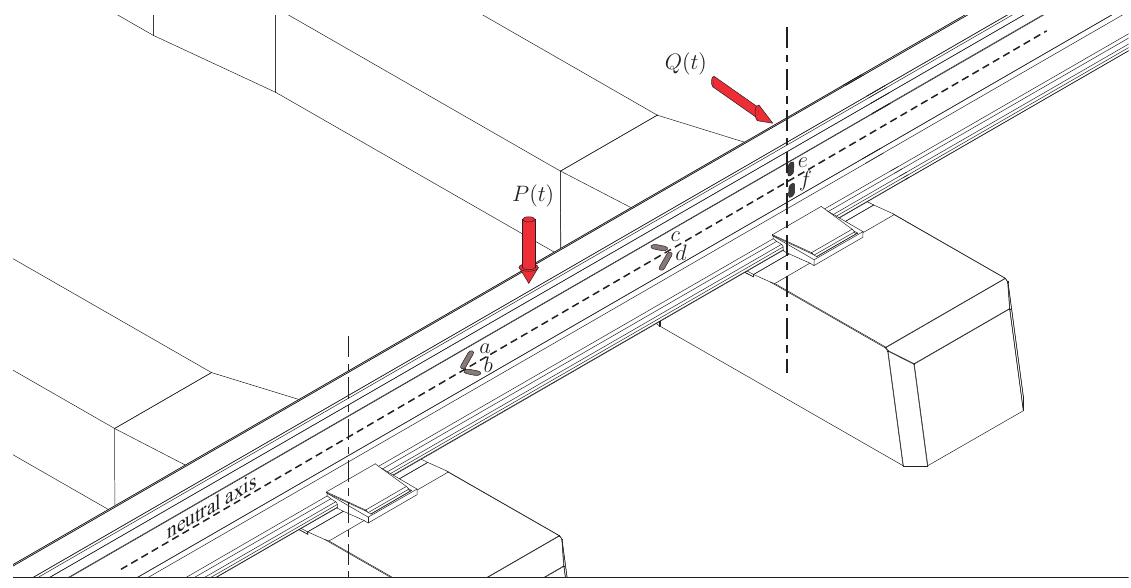
Figure 11. Wheel/rail vertical and lateral forces estimation using strain gage